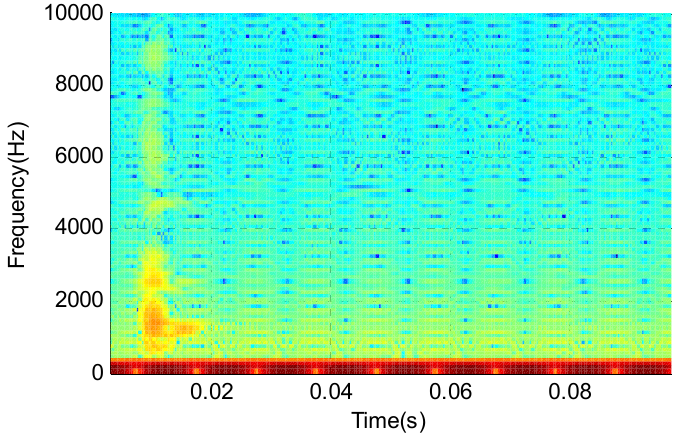
Figure 3. Time-frequency spectrum of switching no-load line.